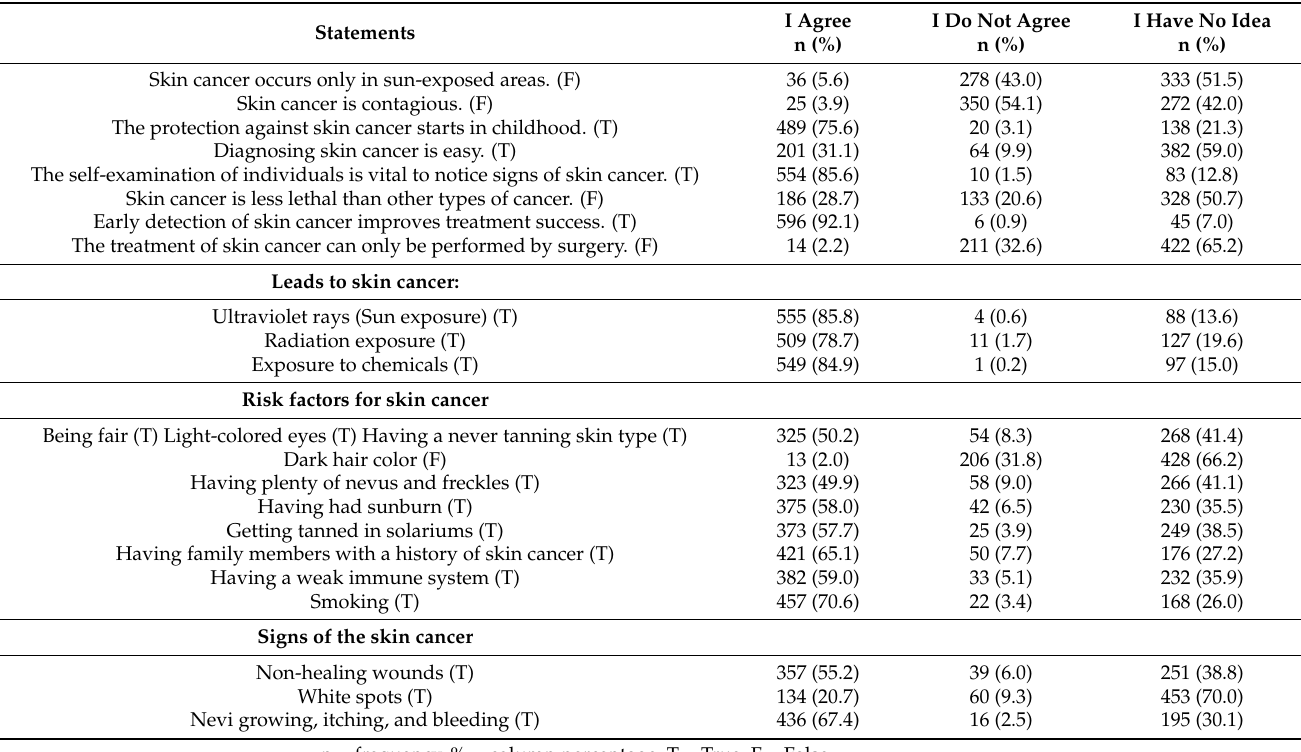
Table 4. The responses of teachers to knowledge